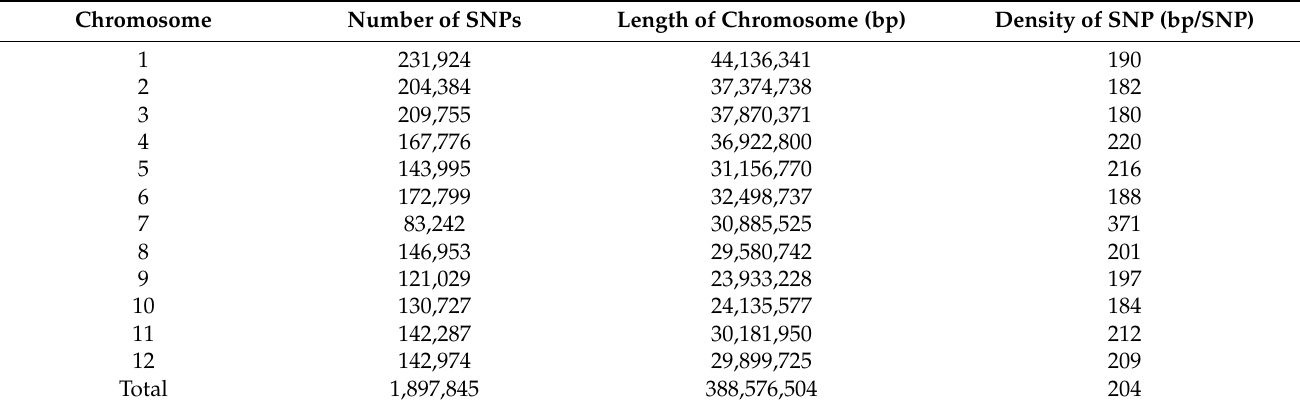
Table 1. Distribution of single nucleotide polymorphisms (SNPs) across 12 rice